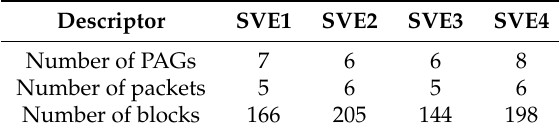
Figure 5. Representation of the four used martensitic statistical volume elements, including the corresponding pole figures characterising the crystallographic features of each realisation. Table 3. Morphological properties of the considered statistical volume